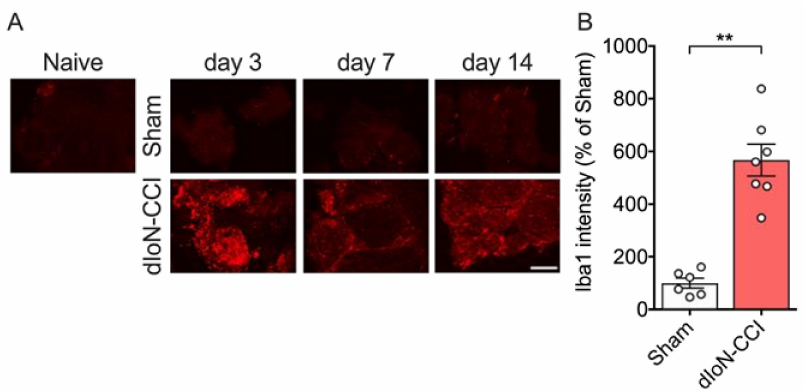
Figure 3. Macrophage accumulation around infraorbital nerve (IoN) following sham and dIoN-CCI. ( A ) Fluorescent photomicrographs of Iba1, a macrophage marker, of IoN from naïve, sham-operated and dIoN-CCI mice 3, 7, 14 days following surgery. One section was taken from one mouse on Day 3 and Day 7. One section was taken from seven mice on Day 14. Scale bar = 50 µ m. Mean percent Iba1 intensity (percent of sham) ( B ). Data are expressed as individual and mean ± SEM. n = 6–7. ** p < 0.01 compared with sham-operated (unpaired t